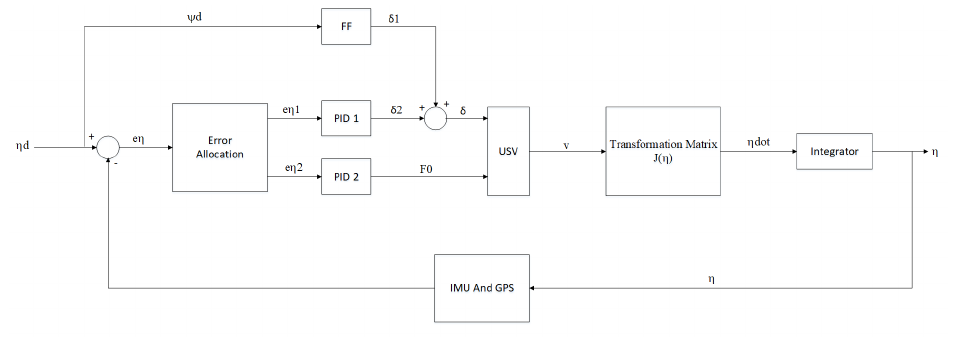
Figure 9. Control scheme employed on the proposed USV.